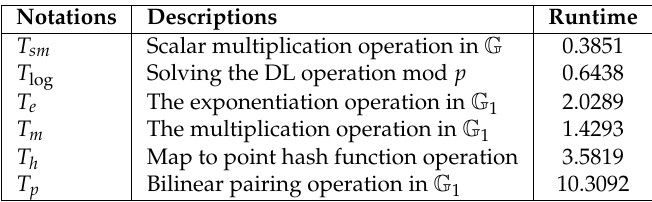
Table 3. Runtime of cryptographic operation